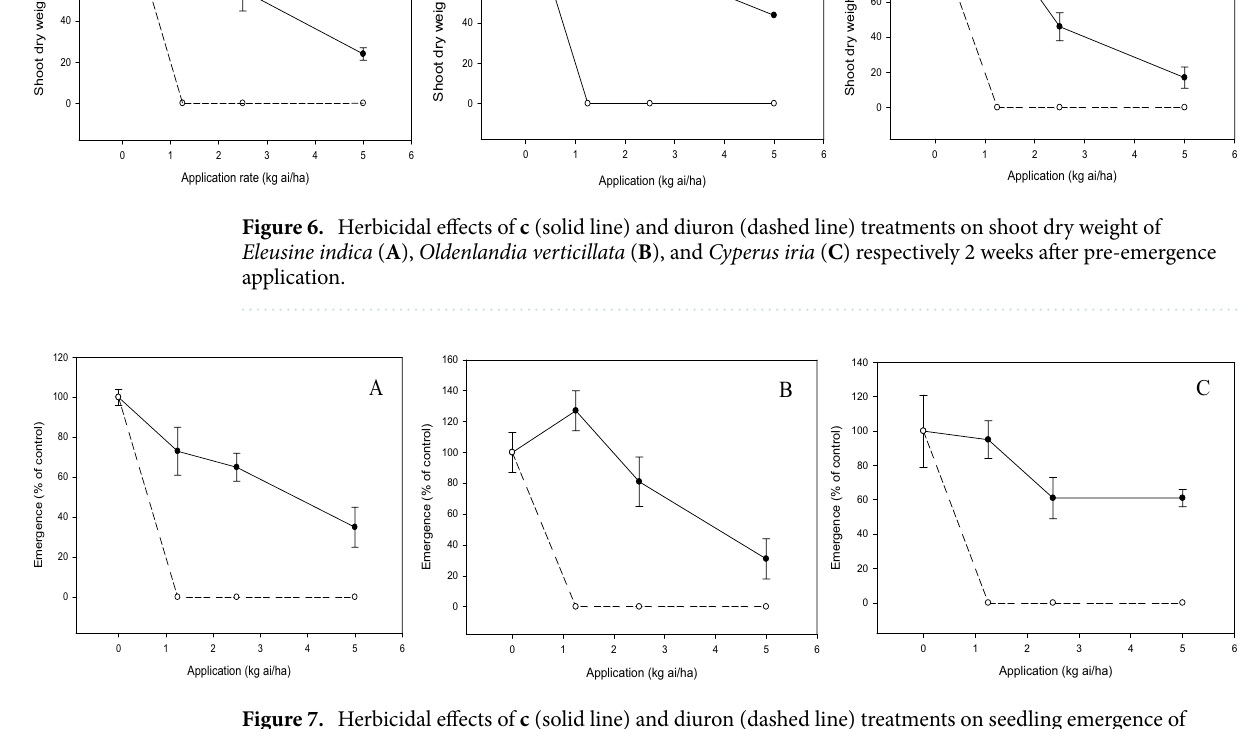
Figure 7. Herbicidal effects of c (solid line) and diuron (dashed line) treatments on seedling emergence of Eleusine indica ( A ), Oldenlandia verticillata ( B ), and Cyperus iria ( C ) respectively 2 weeks after pre-emergence application.